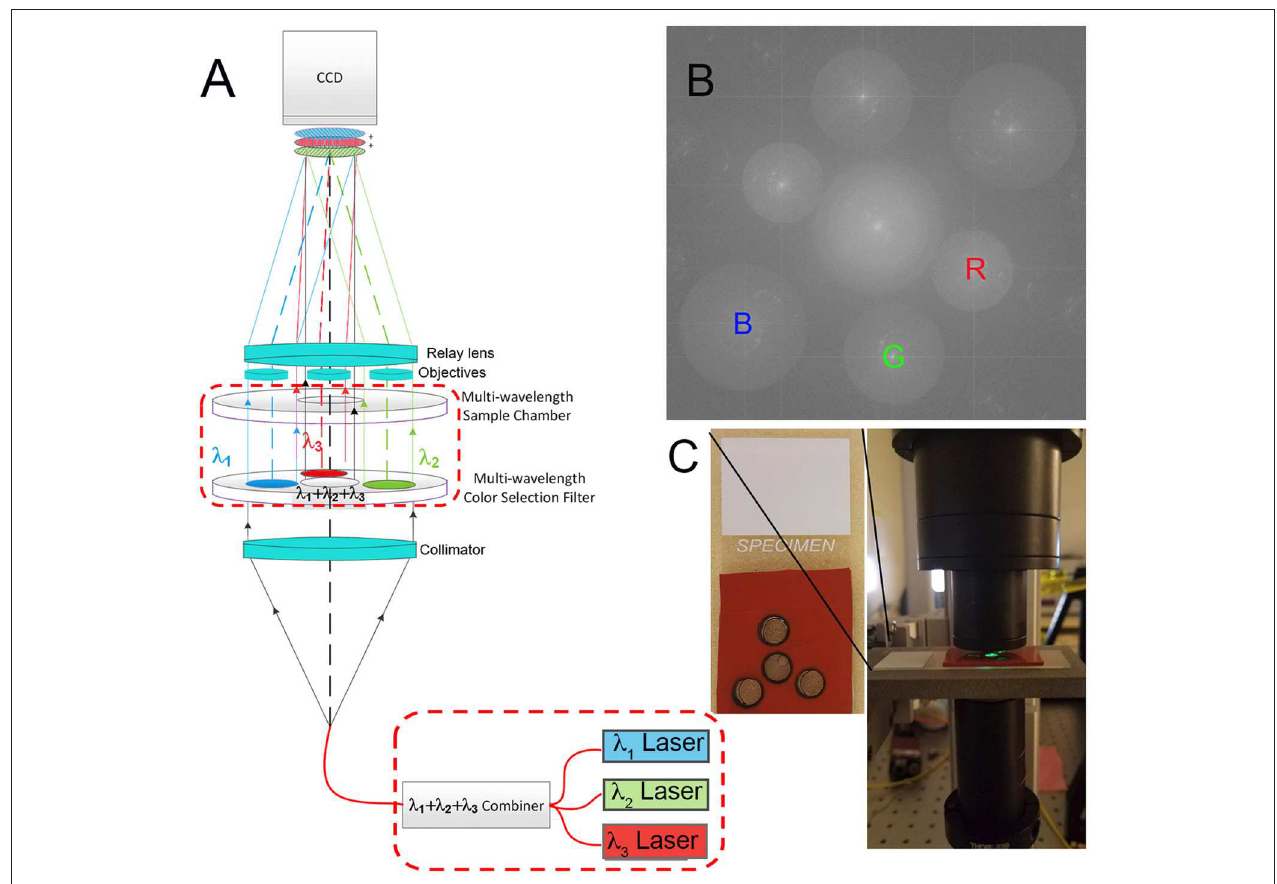
FIGURE 1 | Multiwavelength off-axis DHM. (A) Schematic of the microscope design. Instrument part specifications are as in Wallace et al. [22], with the dashed red boxes indicating modifications for the multiwavelength design as specified here. (B) Fourier pattern showing spatially separated frequencies corresponding to the red, green, and blue laser lines. Each could be filtered separately for reconstruction. (C) Photo of a sample chamber and its positioning in the instrument. The spacing of each hole was determined precisely with a template, and the chamber was aligned by verifying that fringes could be seen using each wavelength separately.